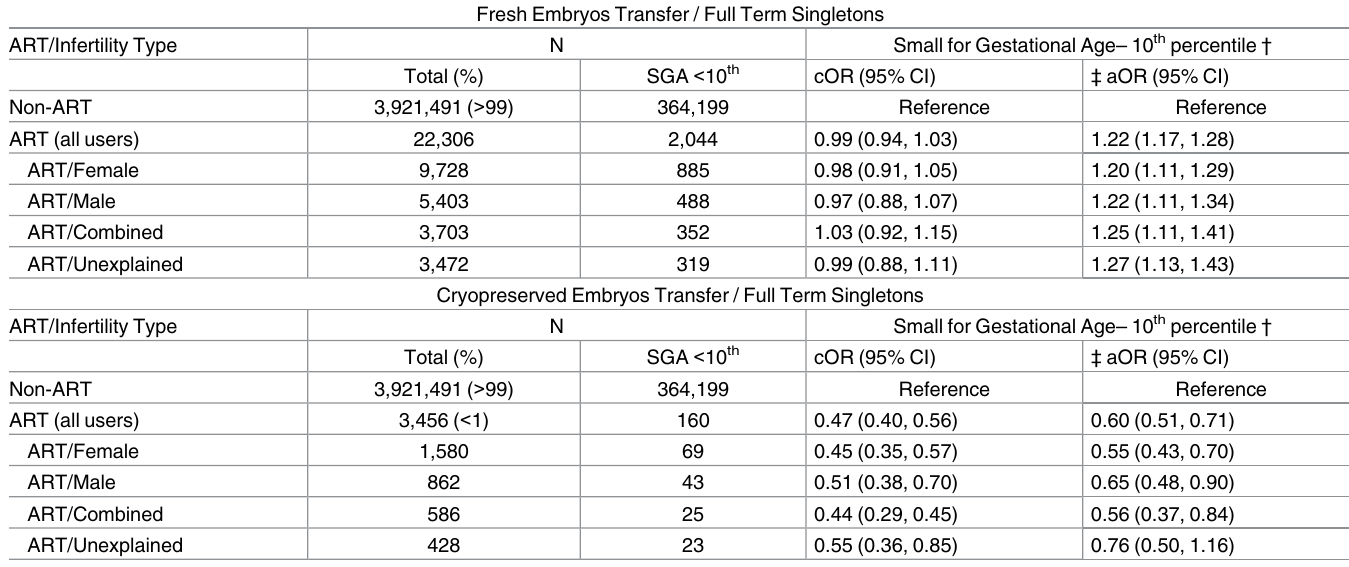
Table 3. Associations between full-term newborn size and ART singletons born following fresh or cryopreserved embryos transfer, using non- ART as the referent group. Population-baseddata of all singletonlive births in Florida and Massachusetts 2000–2010and in